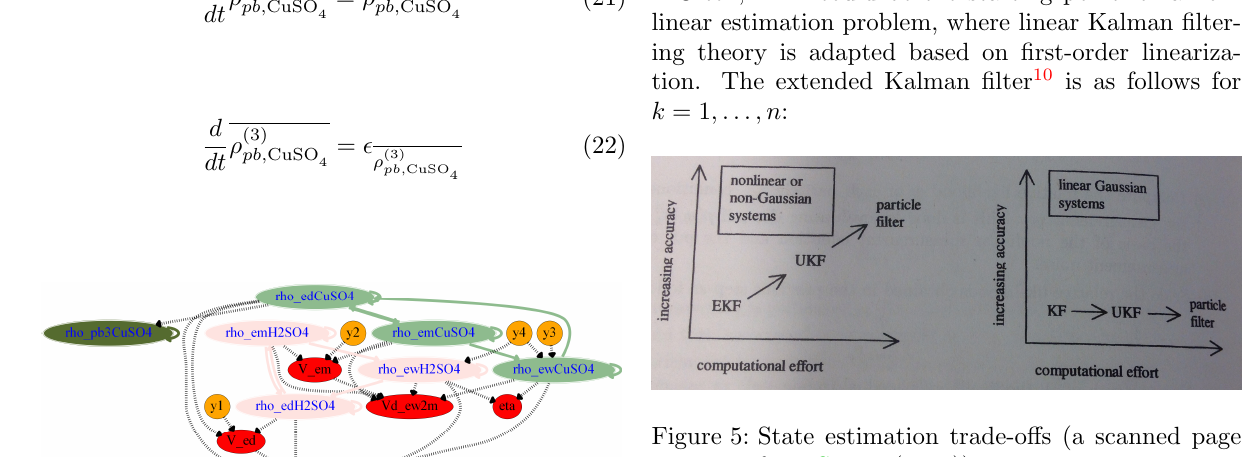
Figure 5: State estimation trade-offs (a scanned page from Simon